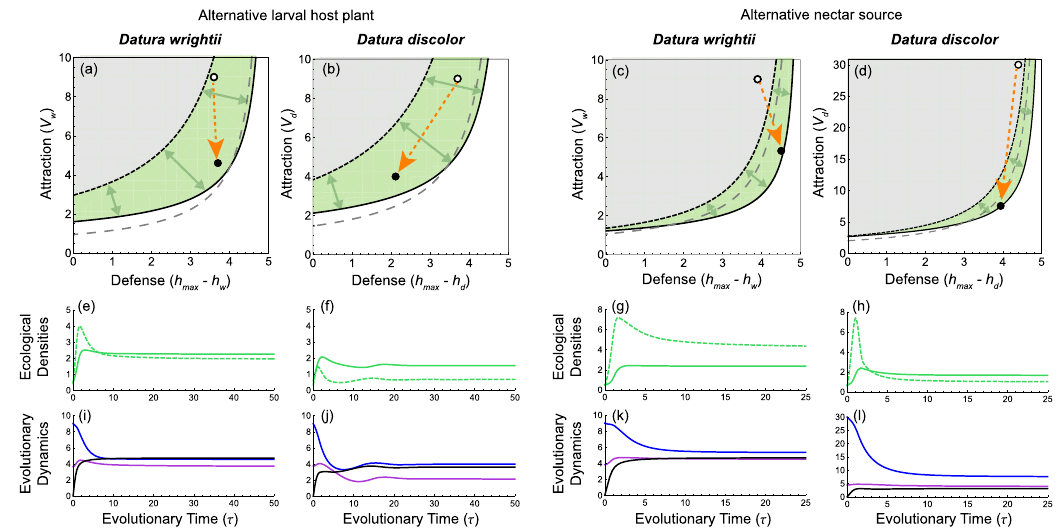
Fig. 4 Coevolutionary transitions in more generalized trophic interactions. Interaction outcomes in the presence of an alternative larval host plant (panels a , b ) or an alternative nectar source (panels c , d ) are plotted as a function of attraction ( v i ) and defense ( h max – h i ), where h max is the maximum herbivory rate. The ancestral insect persists as a pure antagonist above the dashed gray lines and is extinct below. The insect persists as a net antagonist within the gray regions and is extinct within the white regions. Plant evolution of pollination bene fi ts ( b i > 0) expands the green mutualistic regions by moving the interaction breakdown boundary (solid black line) away from the interaction transition boundary (dotted black line), as depicted by green arrows (see Supplementary Movies 4 and 5). Simultaneously, coevolution of attraction and defense drives the transition to net mutualism, as depicted by orange arrows from ancestral coESSs (white points) to new coESSs (black points). Empirical estimates of the coESSs are not included due to data limitations. Panels ( e – h ) plot the equilibrium densities of each Datura species (solid green lines) and insect larvae per plant of each Datura species (dashed green lines) over evolutionary time, τ . Panels ( i-l) plot the coevolutionary dynamics of pollination bene fi ts ( b i ; black lines), attraction ( v i ; blue lines), and defense ( h i ; purple